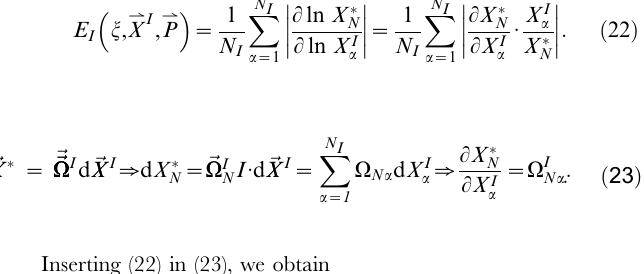
Figure S2 Correlation between robustness to input and parameter perturbations within TR and NP networks before the cutoff. Correlation between log